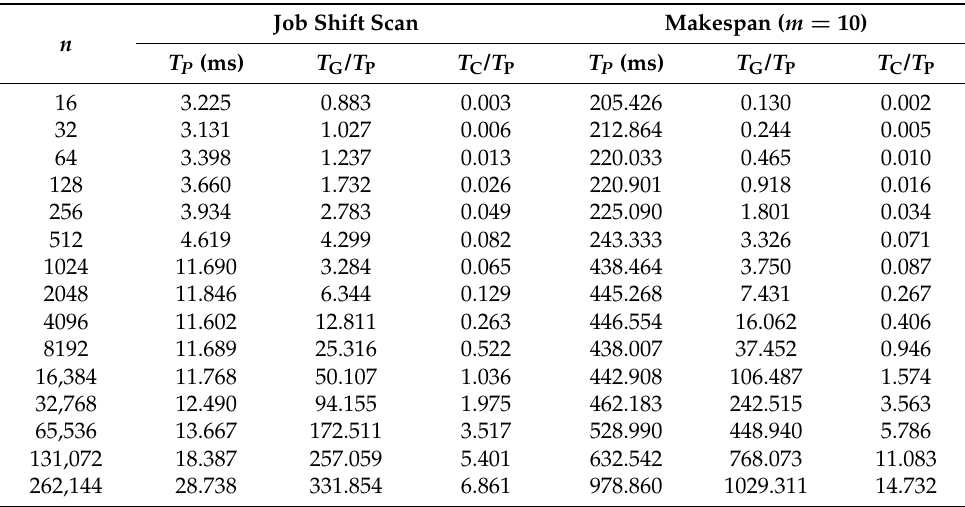
Table 3. Running times and speedups for CPU (C); GPU sequential (G); and GPU parallel (P) job shift scan and makespan calculations.